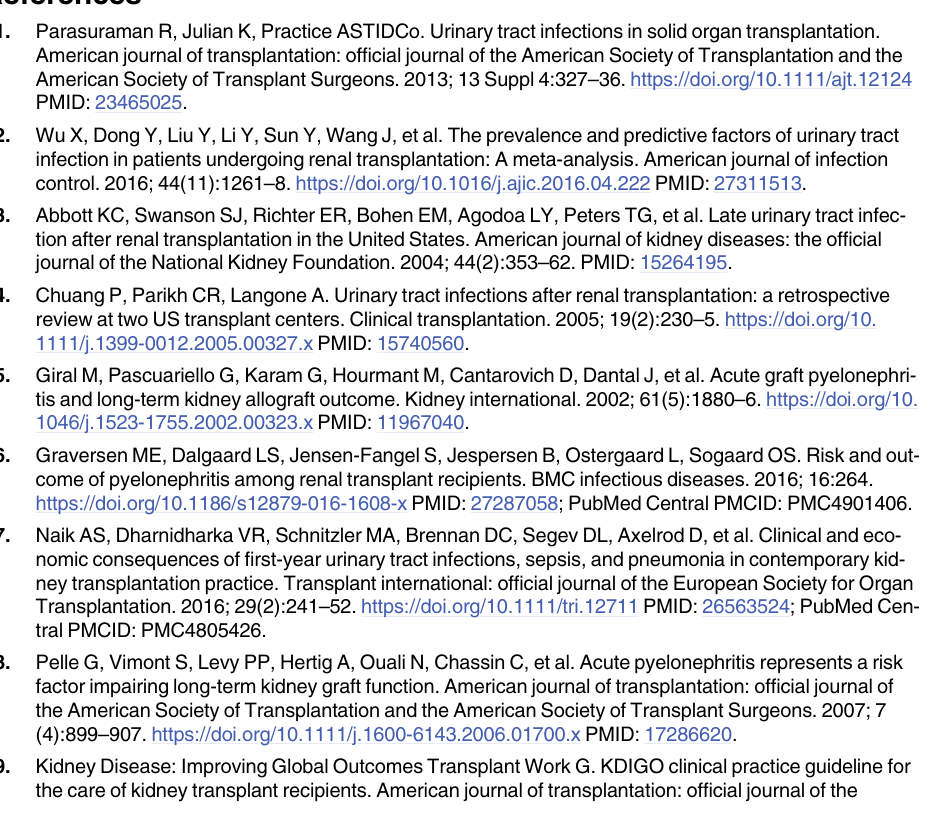
S2 Table. Factors associated with biopsy-proven acute cellular